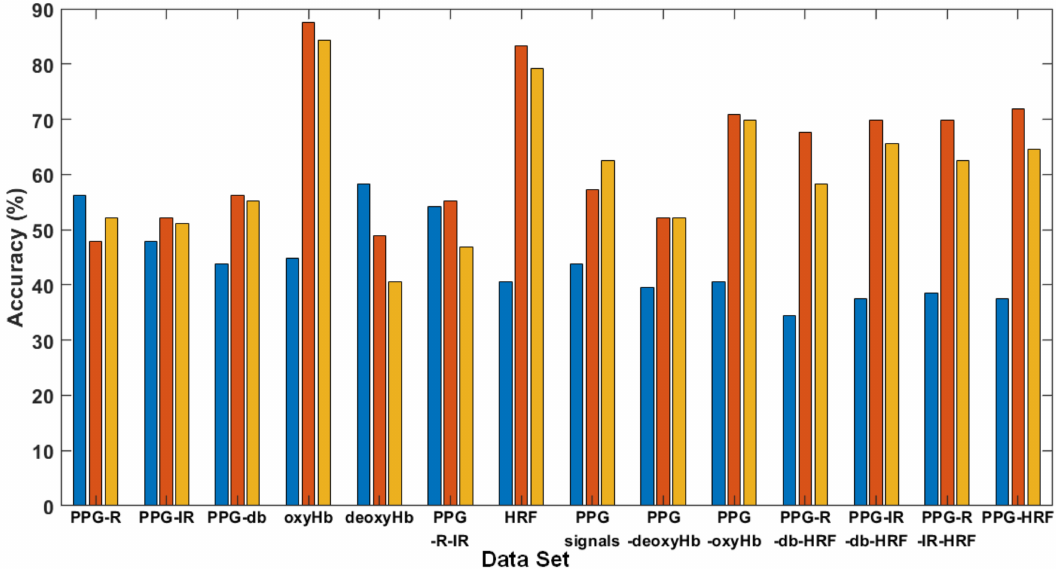
Figure 8. Accuracy comparison for 14 types of data and three kernel functions: linear, quadratic, and cubic.